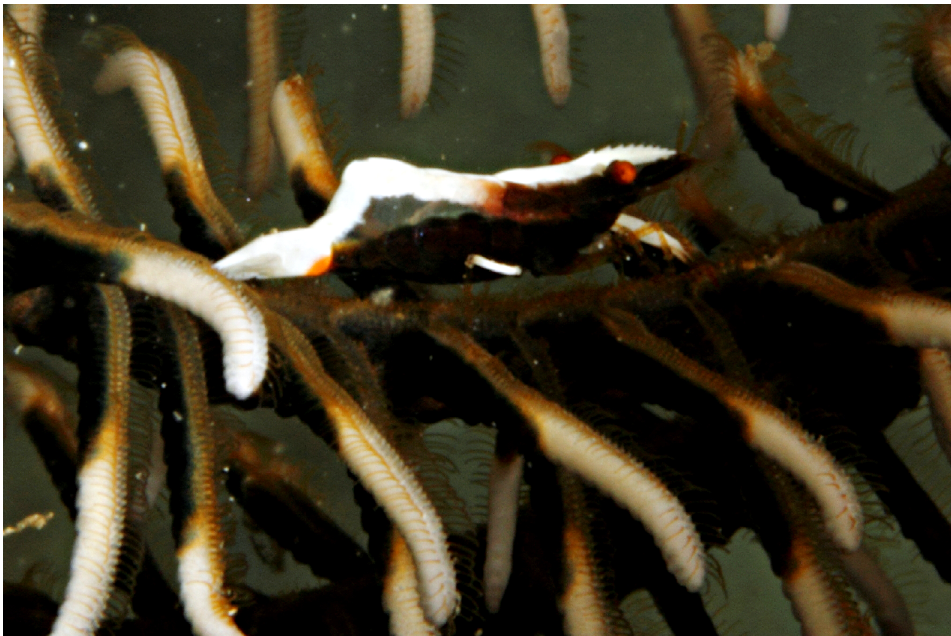
Figure 3. Ovigerous female of Periclimenes crinoidalis (CL 2.36 mm), associated with the crinoid Nemaster grandis , in Chichiriviche de la Costa, Vargas State, Venezuela.